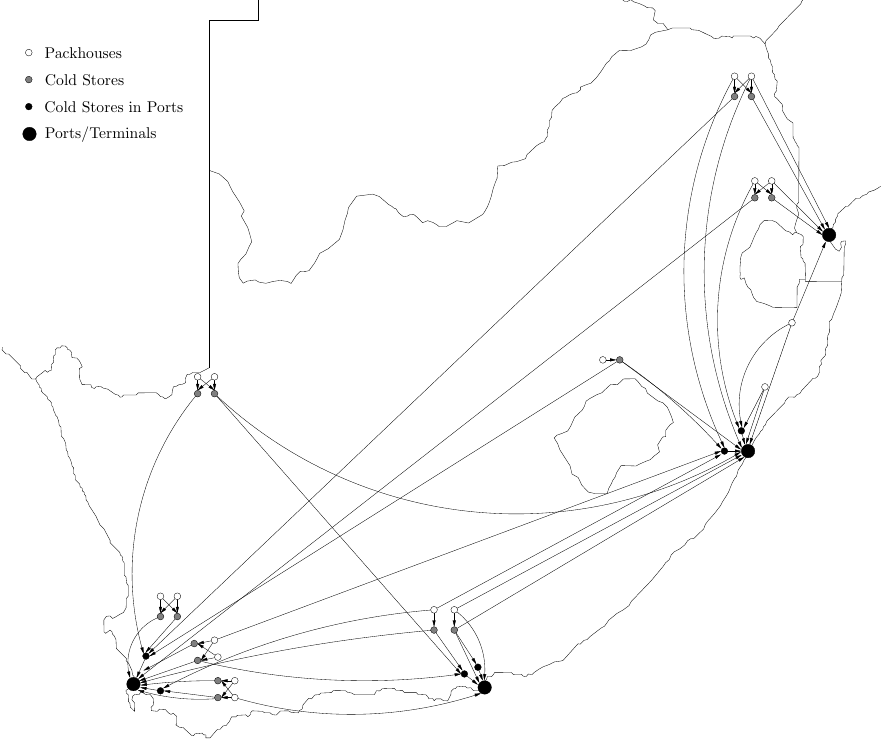
Figure 3: Simplified schematic representation of the South African fruit export infrastructure network (the majority of fruit regions have been omitted from the figure for the sake of